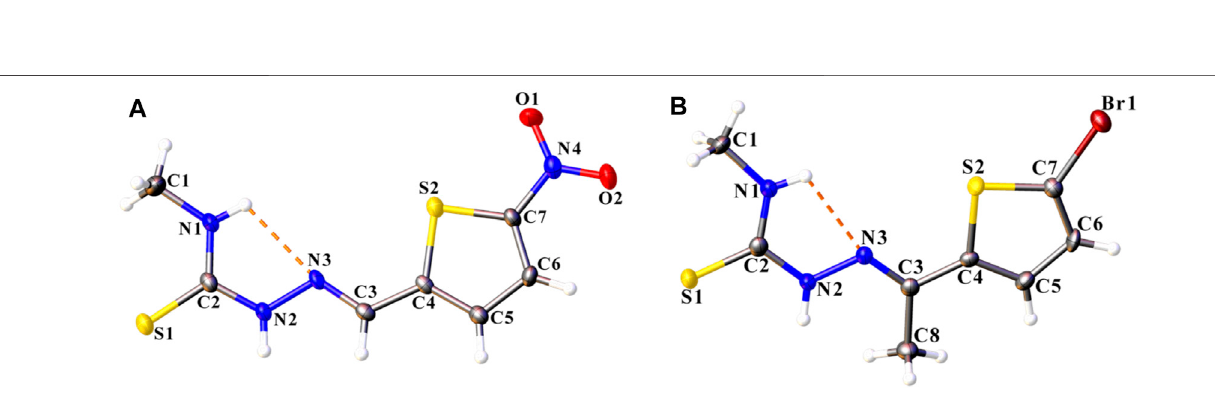
Frontiers in Pharmacology |